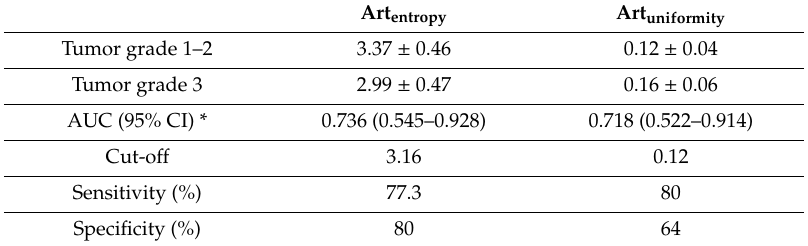
* Area under the curve (95% confidence